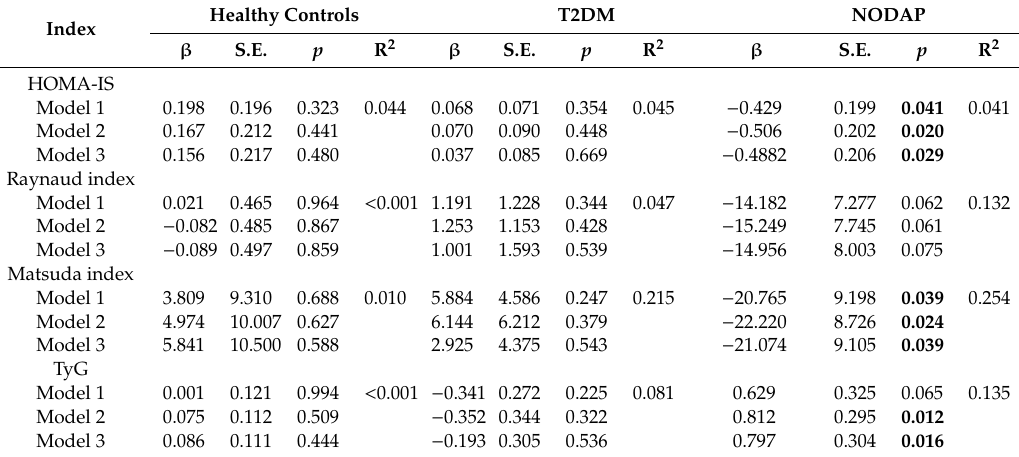
Table 6. Associations between subcutaneous fat volume and indices of insulin sensitivity in non-obese individuals.